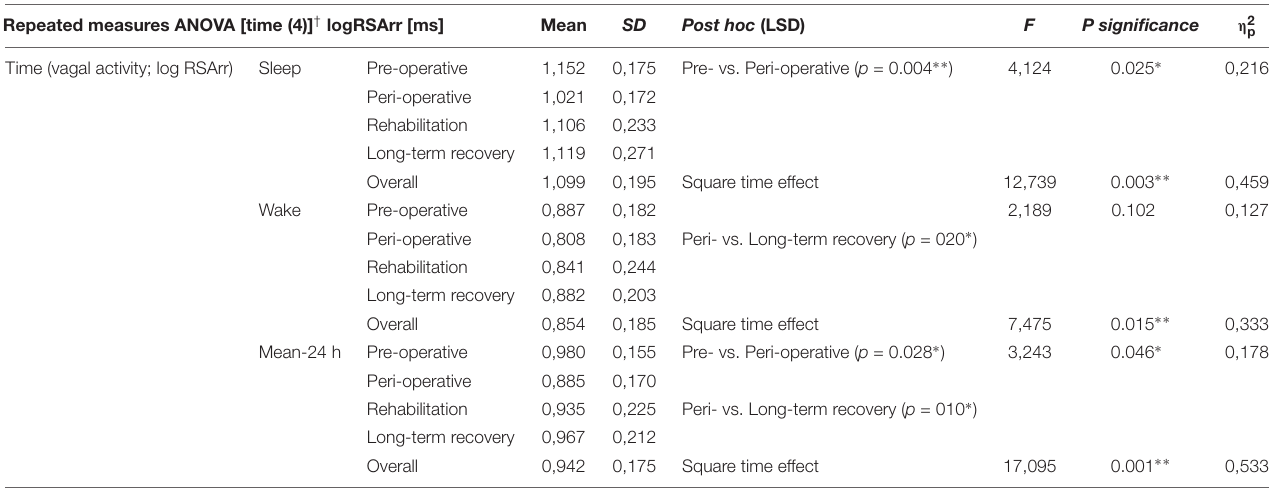
TABLE 1 | Statistical significance of vagal activity differences over